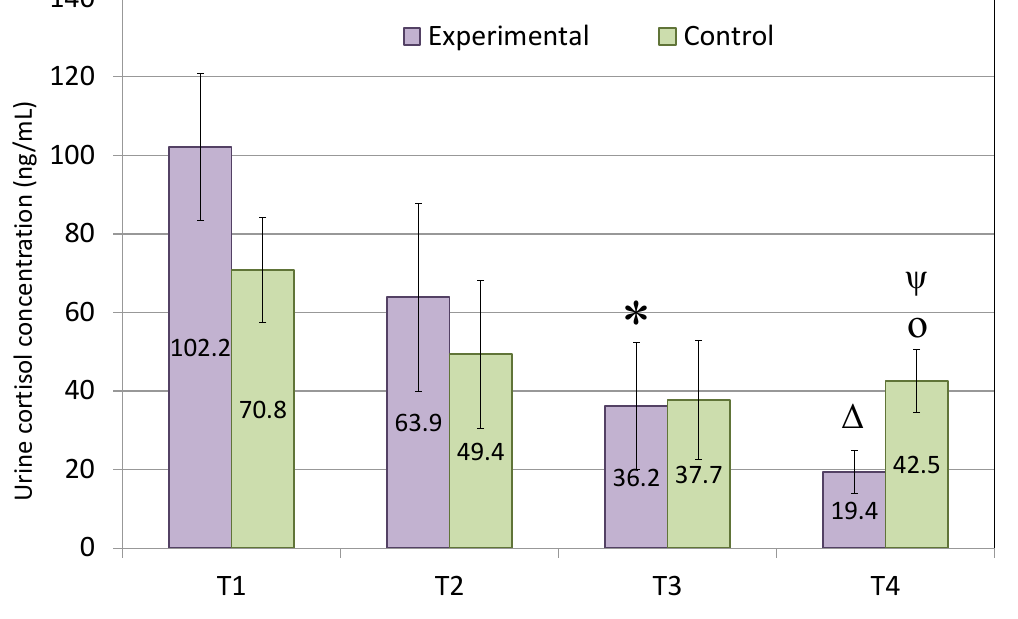
Figure 5. Dynamics of urine cortisol concentration of the swimmers from the experimental (n=12) and the control (n=12) groups on the 1 st (T1), 14 th (T2), 28 th (T3) and 42 nd (T4) days of the six- week training period. * - p < 0.05 vs Experimental T1; Δ - p < 0.05 vs Experimental T1 and T2; O - p < 0.05 vs Control T1; ψ - p < 0.05 vs Experimental